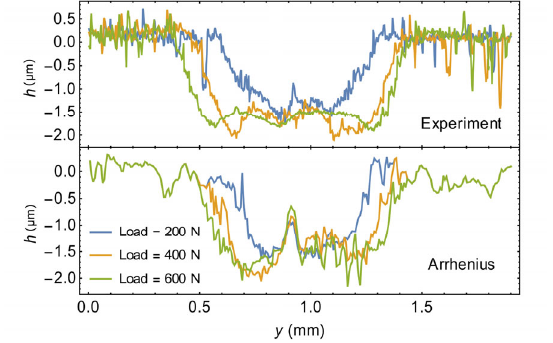
Fig. 13 Comparison of the wear profile on the center section perpendicular to speed.